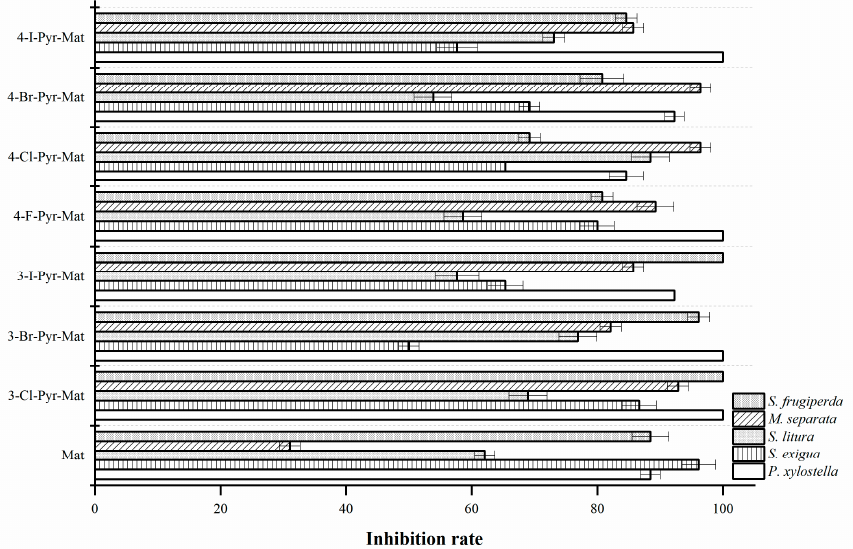
Figure 1. Insecticidal activity of matrine and its derivatives against agricultural pests at concentration of 1.0 mg/mL. Table 2. Toxicities of matrine and its derivatives to agricultural pests.